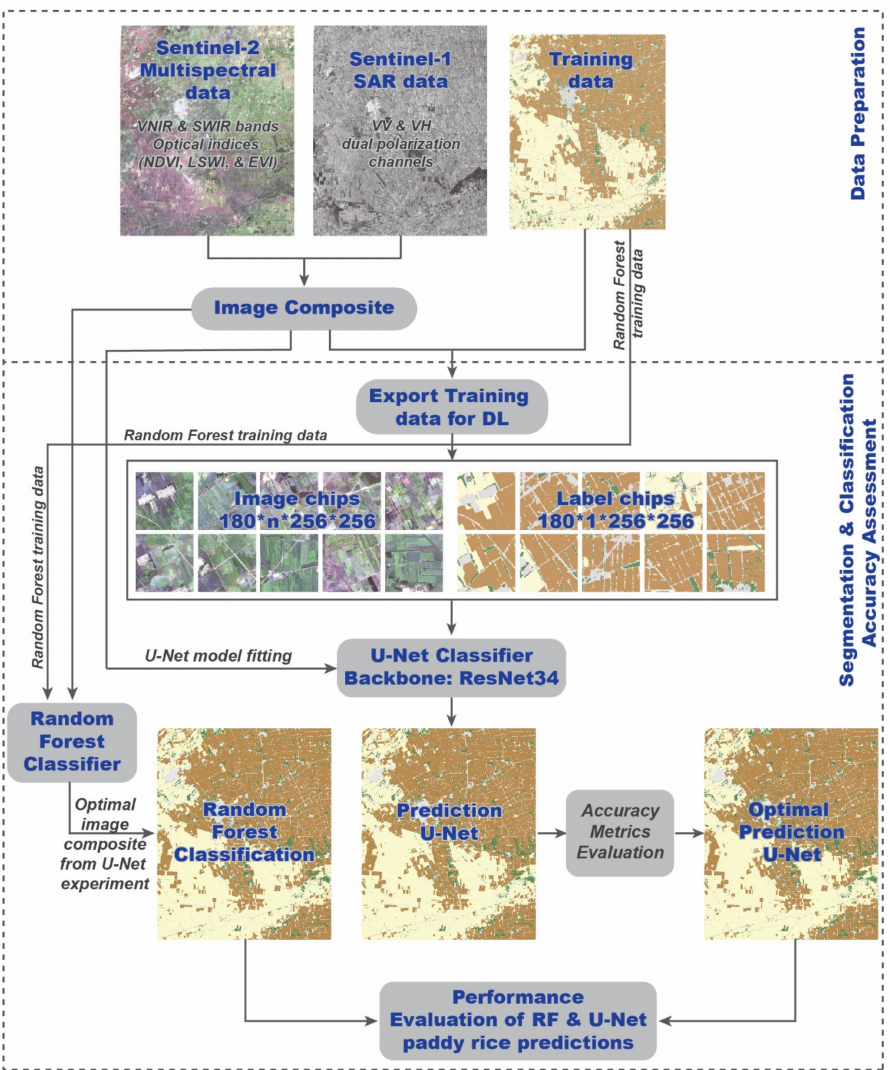
Figure 2. Proposed workflow for paddy rice mapping adapted in this study. The image chip dimensions were 256 × 256 pixels (n = the number of bands of input image composites used for deep learning